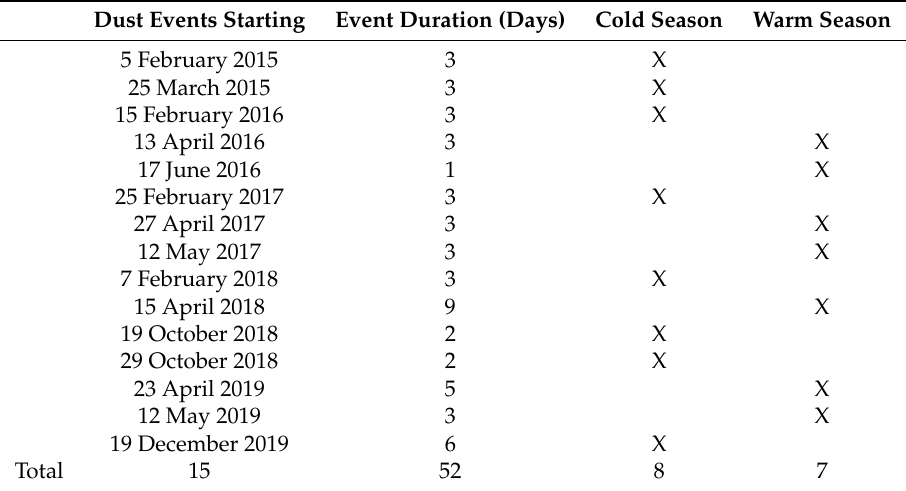
Table 2. Dust events, their duration and identification in cold and warm season. Dust Events Starting